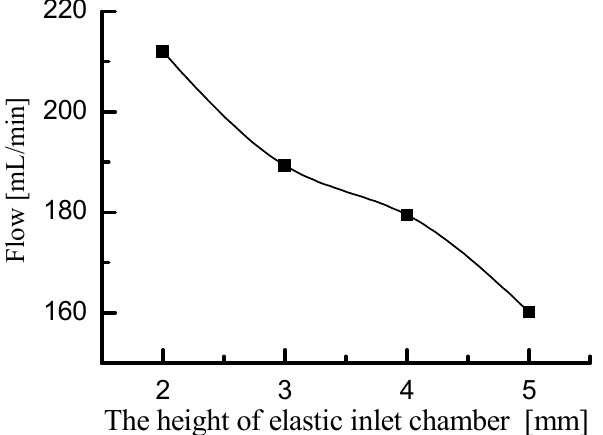
Figure 6. The simulation results of elastic inlet cavity. ( a ) Elastic inlet cavity with height of 2 mm, ( b ) elastic inlet cavity with height of 3 mm, ( c ) elastic inlet cavity with height of 4 mm, and ( d ) elastic inlet cavity with height of 5 mm. The metric for color bar: left color bar-m/s, right color bar-pa.